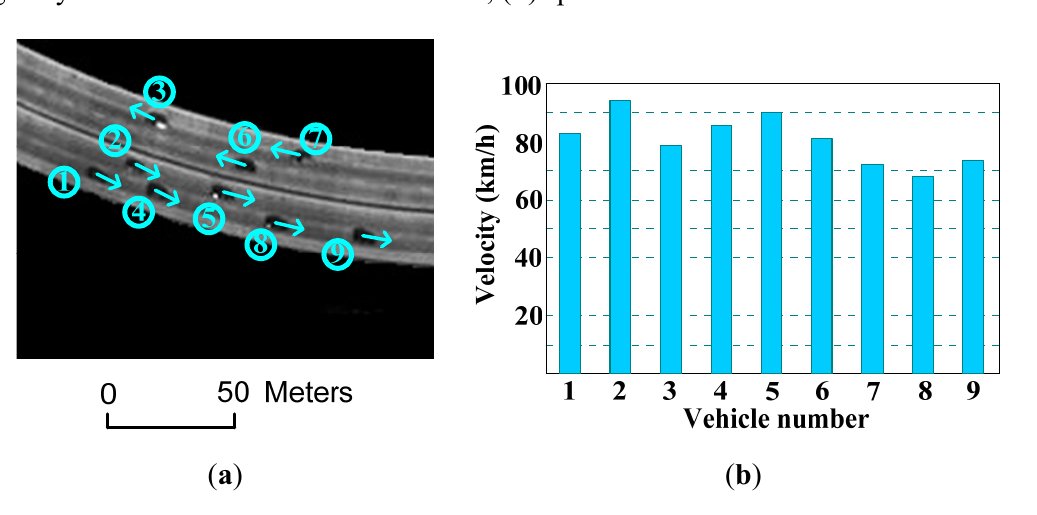
Figure 20. Results of moving vehicles’ speed and direction estimation: ( a ) vehicles on a highway labeled with movement directions; ( b ) speed estimation